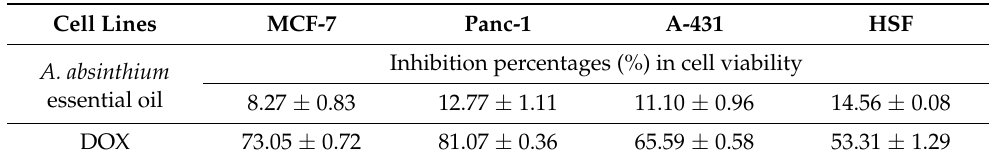
Table 4. Cytotoxic activity of 100 µ g/mL A. absinthium essential oil and doxorubicin against different tested cell